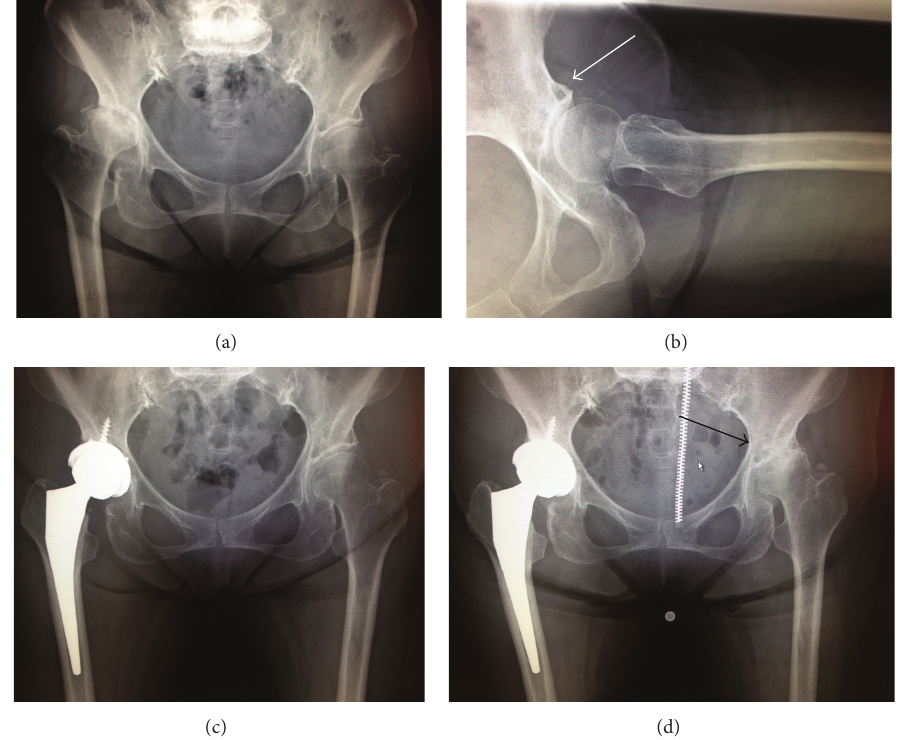
Figure 1: Consequent X-ray of the hip. At the time of right THA, left hip had enough joint space with bone cyst at anterior acetabulum ((a), (b); white arrow). Postoperative X-ray (c). 8 months after right THA, left hip had the end stage of osteoarthritis (black arrow; (d)).